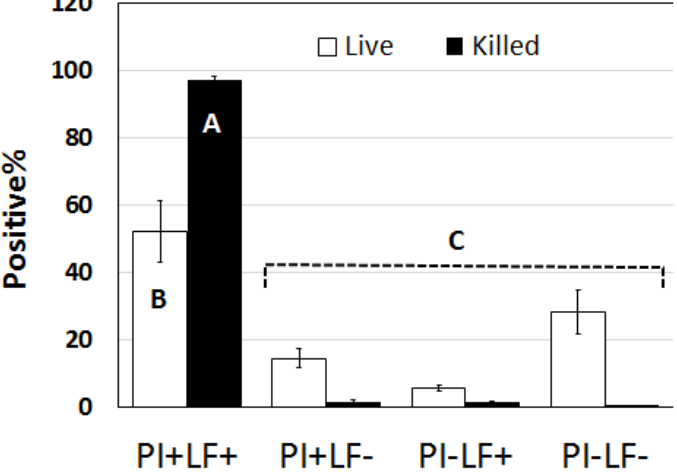
Figure 8. The proportion of untreated (live) or killed (snap-frozen) sperm positive for PI or LF counted by flow cytometry with very similar results to that seen with visual microscopic count (Figure 7) lending more credence to the validity of our observations. Different letter indicates significant difference p < 0.001.